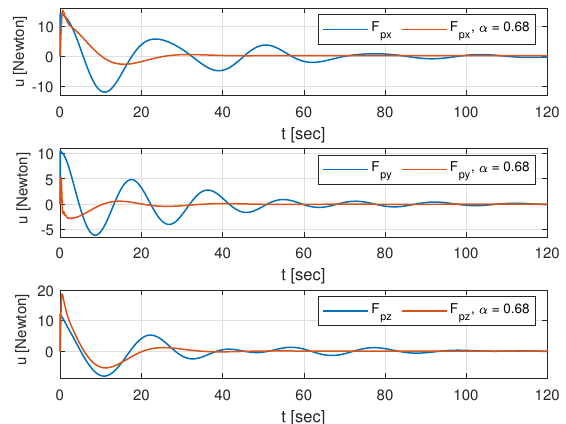
Figure 17. Actuator with larger forces.